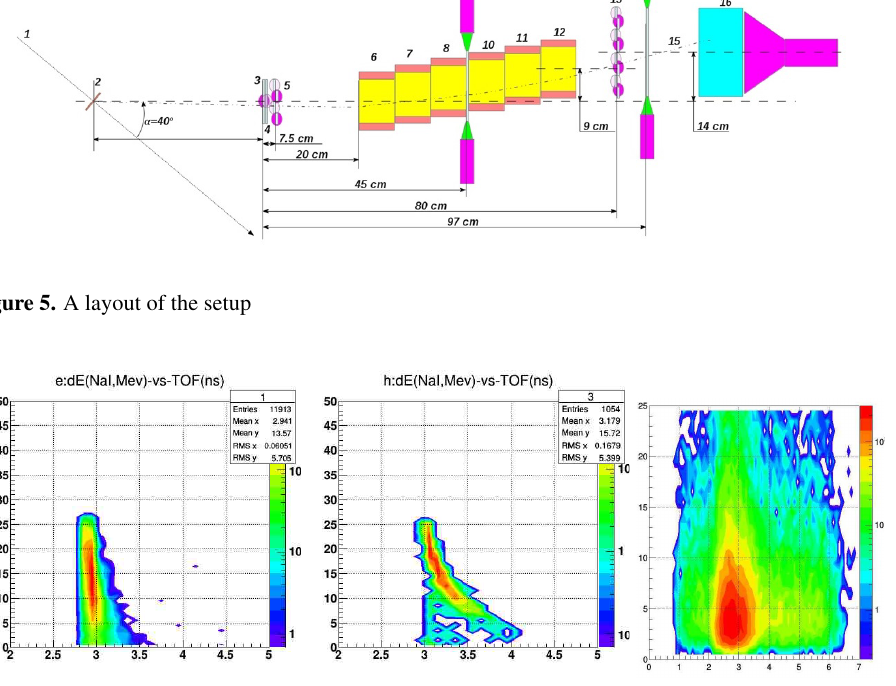
Figure 6. Test run of the setup (right) in comparison with